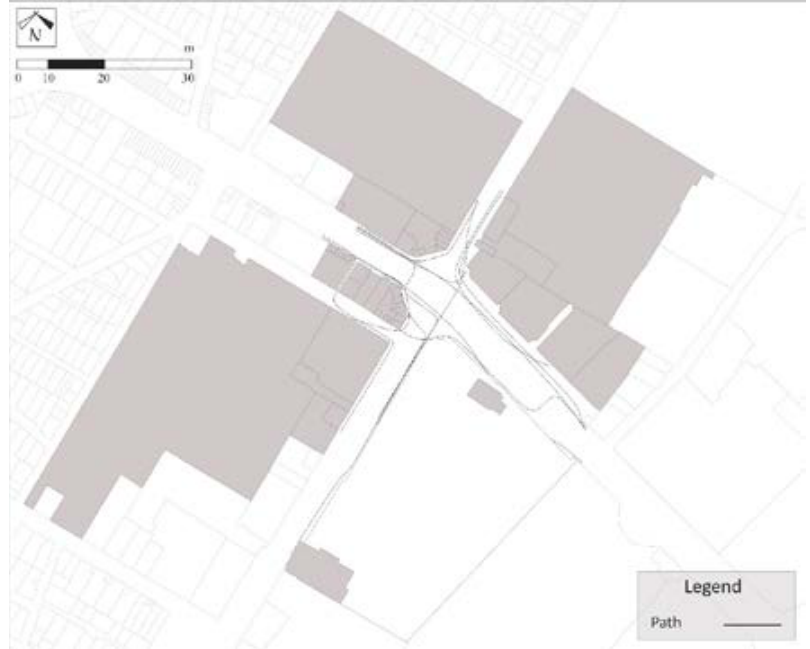
Fig. 10: Tracking the path (noon); source: authors